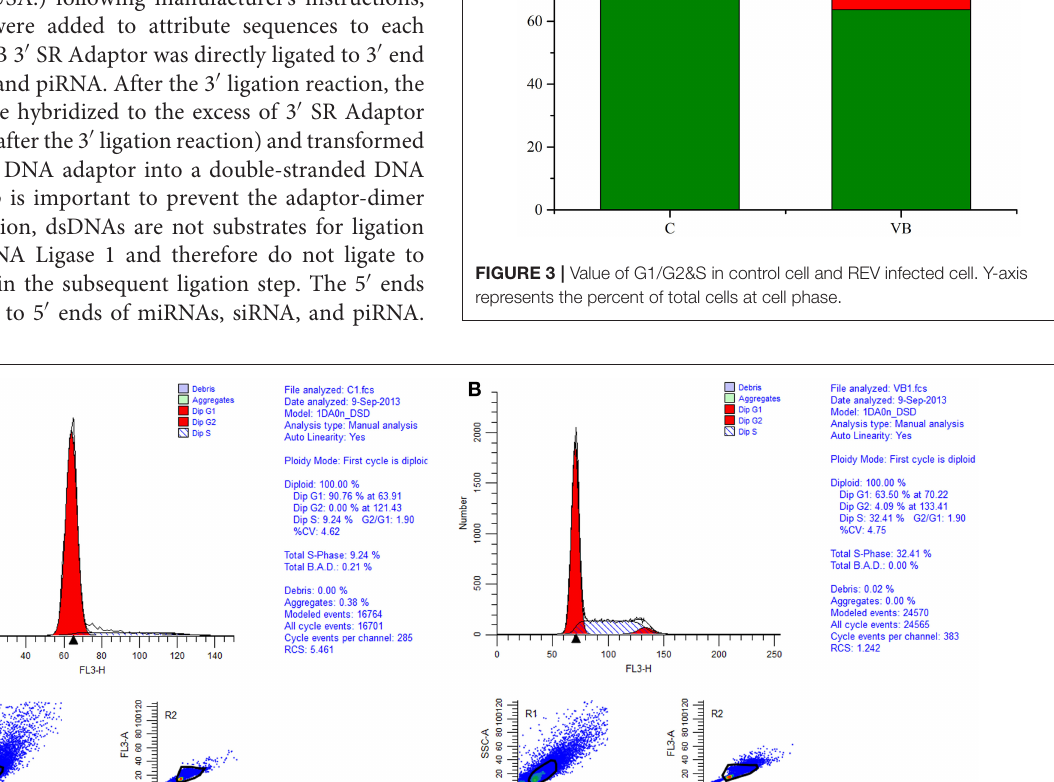
Frontiers in Genetics |